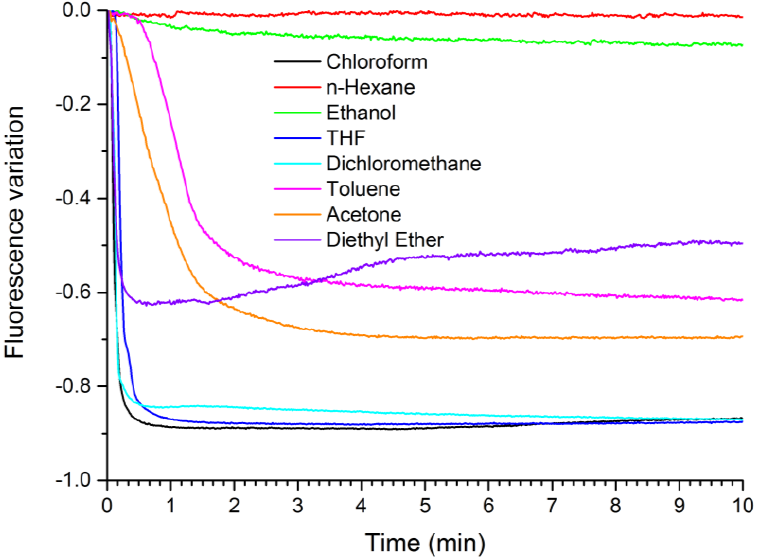
Figure 6. Variation of the fluorescence maximum intensity ( λ exc . = 410 nm) of P(STY-co-JCBF)(0.34) films with exposure time to all VOCs investigated.